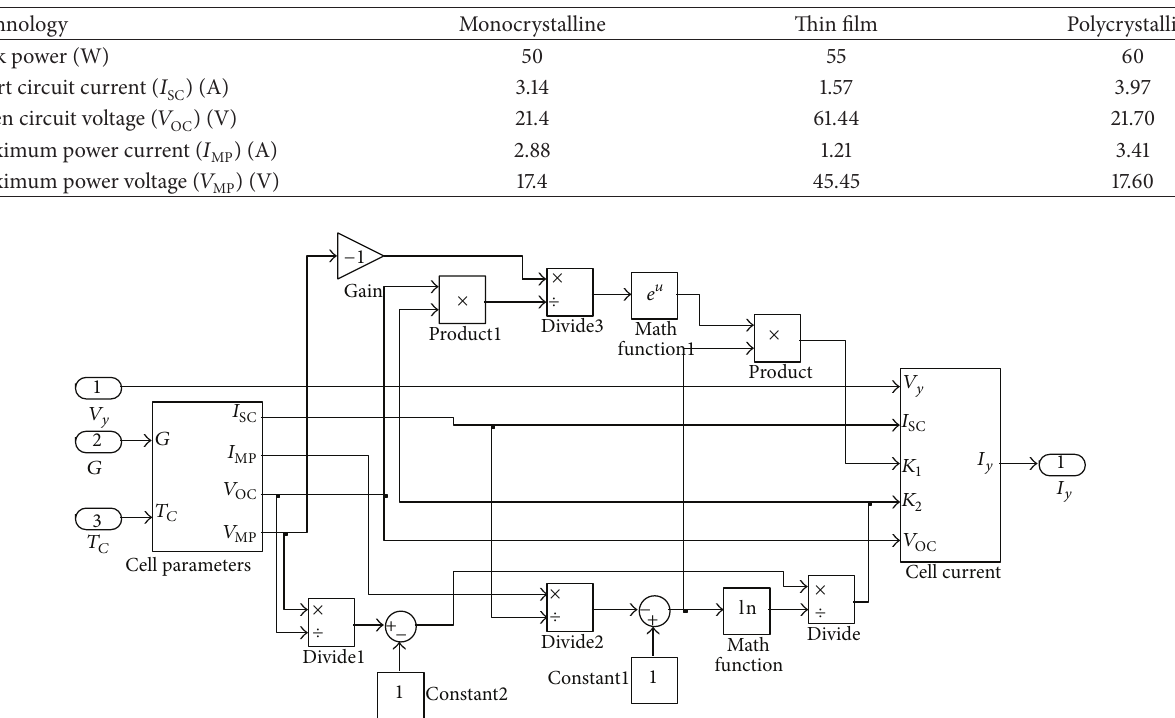
Figure 3: PV panel subsystem block diagram.